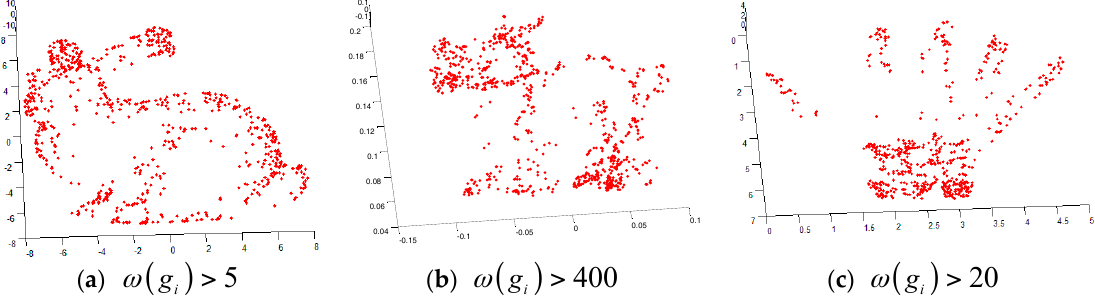
Figure 4. The results of calculation based on point cloud features.